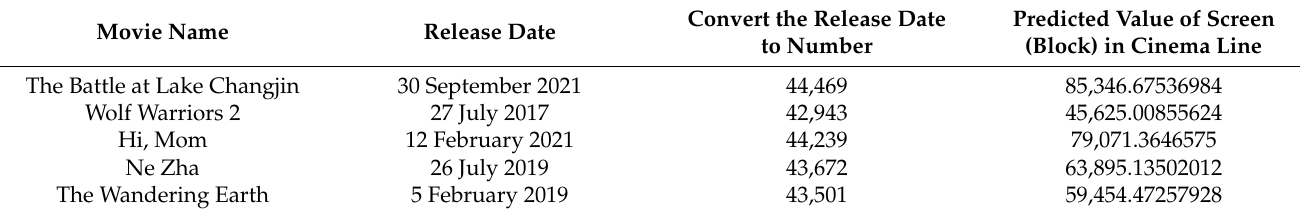
Table 2. Example of Screens (Block) Predict Data in Cinema Line.